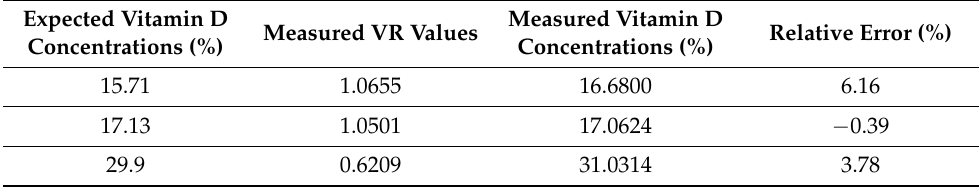
Table 2. Measured vitamin D concentrations (ng/mL) from the calibration equation.